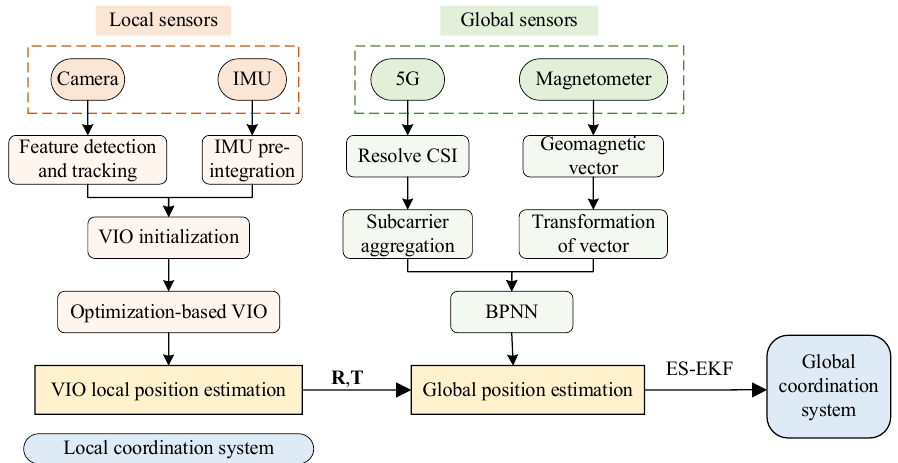
Figure 1. The architecture of the proposed system. R represents the rotation matrix converted from local coordinates to global coordinates and T is the translation matrix.